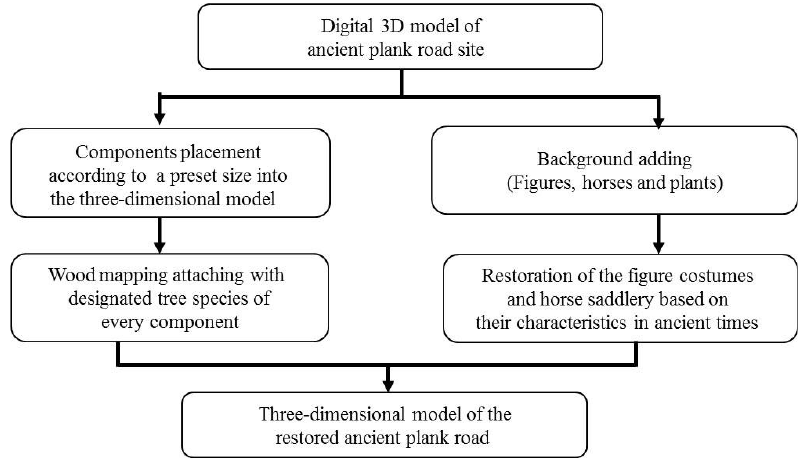
Figure 12. Processing of the virtual restoration of the ancient plank road and showing its results.